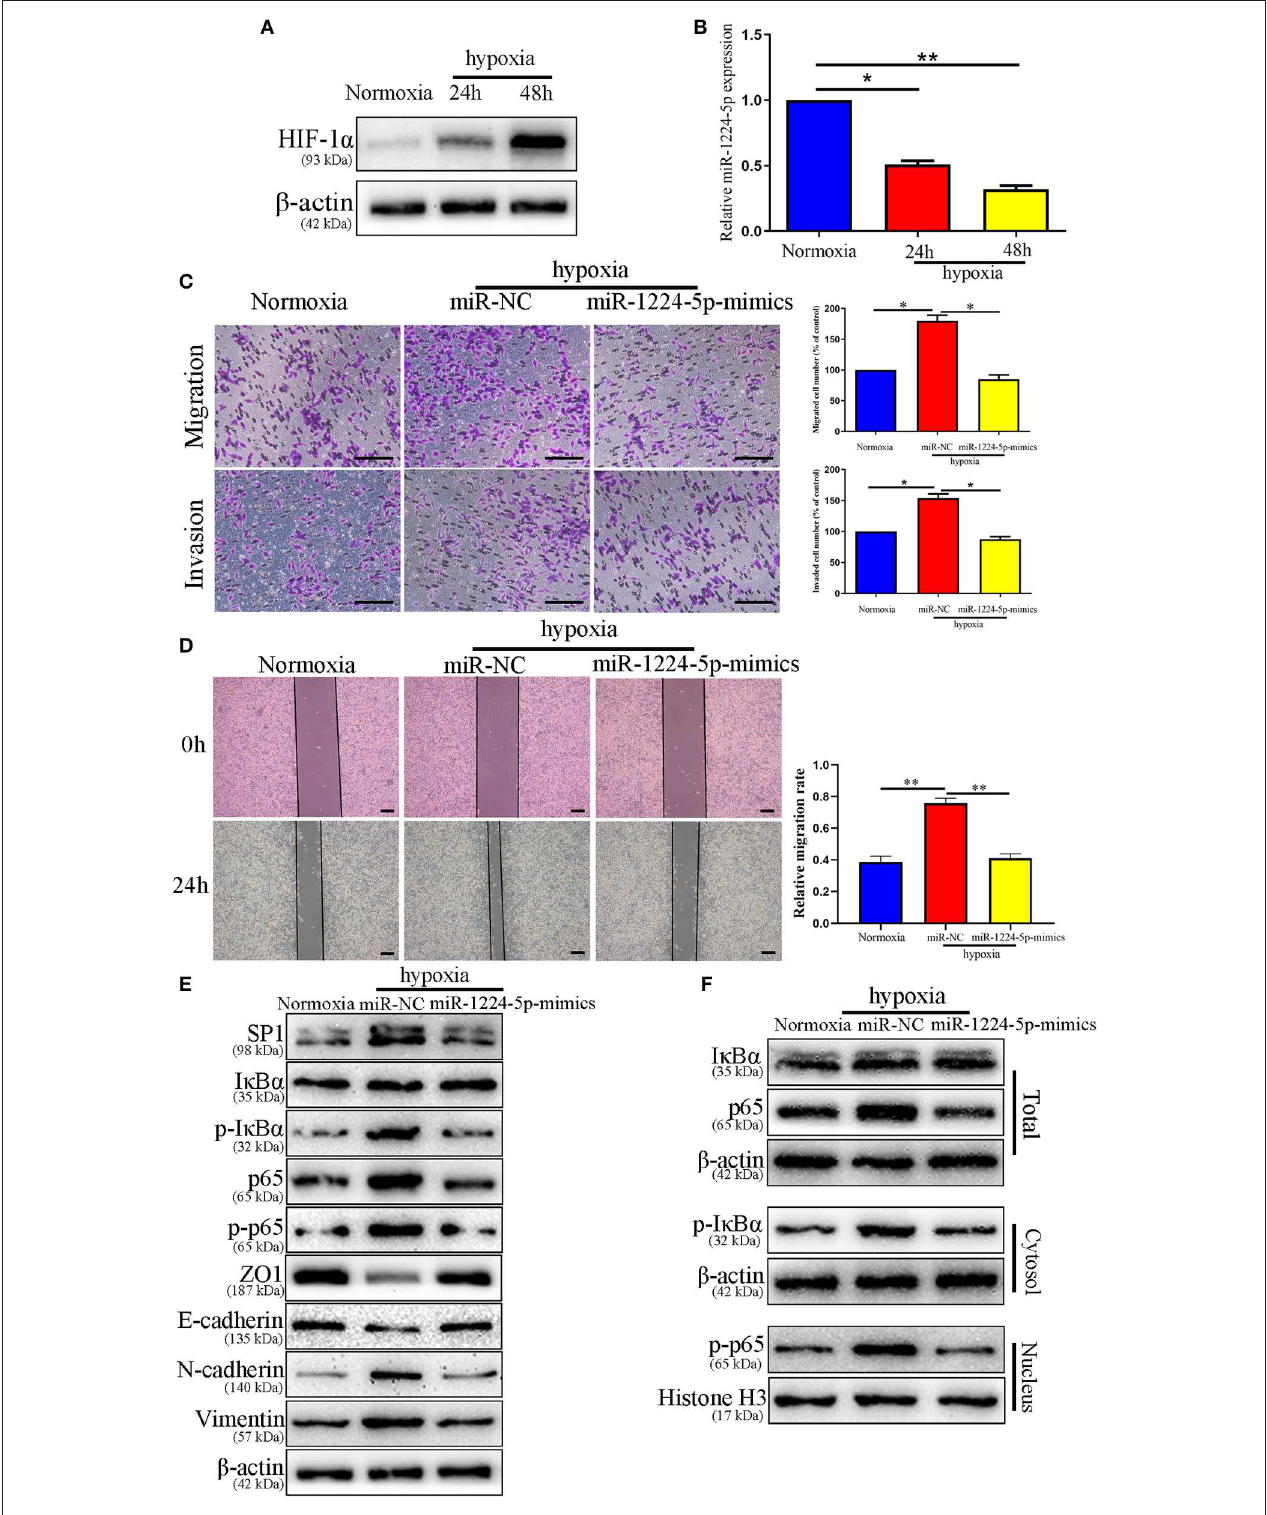
FIGURE 10 | miR-1224-5p mediates the promoting effects of hypoxia on metastasis and EMT of CRC cells. (A) The expressions of HIF-1 α in different time points in normoxia and hypoxia condition. (B) The levels of miR-1224-5p in SW480 cells cultured in normoxia and hypoxia. (C,D) Transwell assays and Wound healing